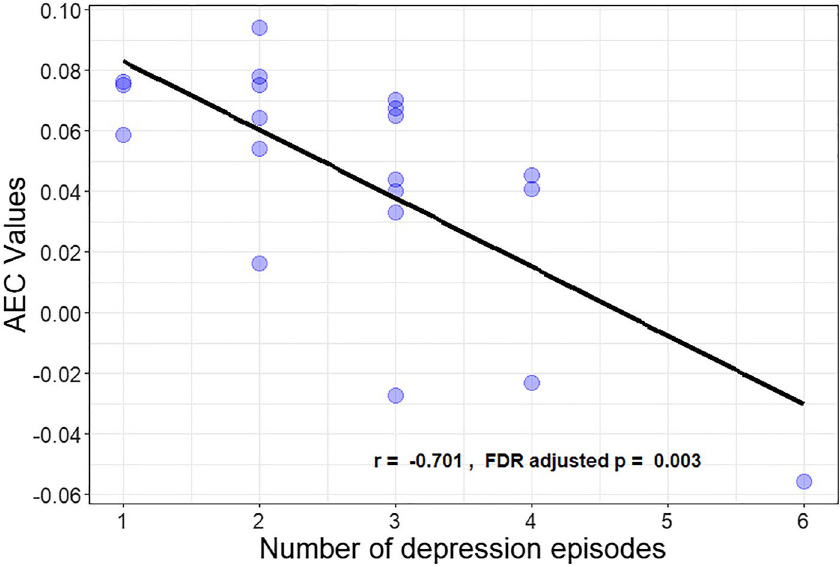
Figure 4. Scatterplot demonstrating the negative association between the number of depression episodes and sgACC–DLPFC Amplitude Envelope Correlation connectivity for depressed patients. Amplitude Envelope Correlation connectivity values from left sgACC–right DLPFC were correlated with the number of depression episodes a patient has had in his/her lifetime, using non-parametric Pearson correlation coefficients. sgACC: subgenual Anterior Cingulate Cortex, DLPCC: Dorsolateral Prefrontal